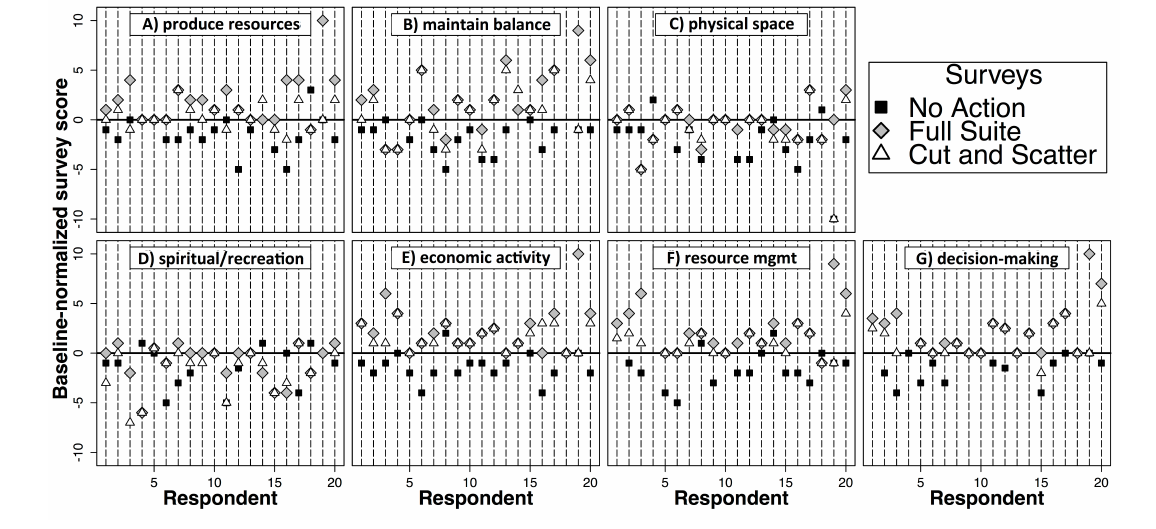
Fig. 3. Participant responses to seven questions concerning the current state of Owyhee County (i.e., baseline) and the Bruneau-Owyhee Sage-Grouse Habitat project alternatives: no action, full suite of actions, and cut and scatter. Results are displayed scored as baseline-normalized by subtracting the participant baseline score from his or her alternative score. Responses about alternatives were normalized to baseline scores (e.g., participant 1 baseline score is 7, full suite score is 8, and the baseline-normalized score is